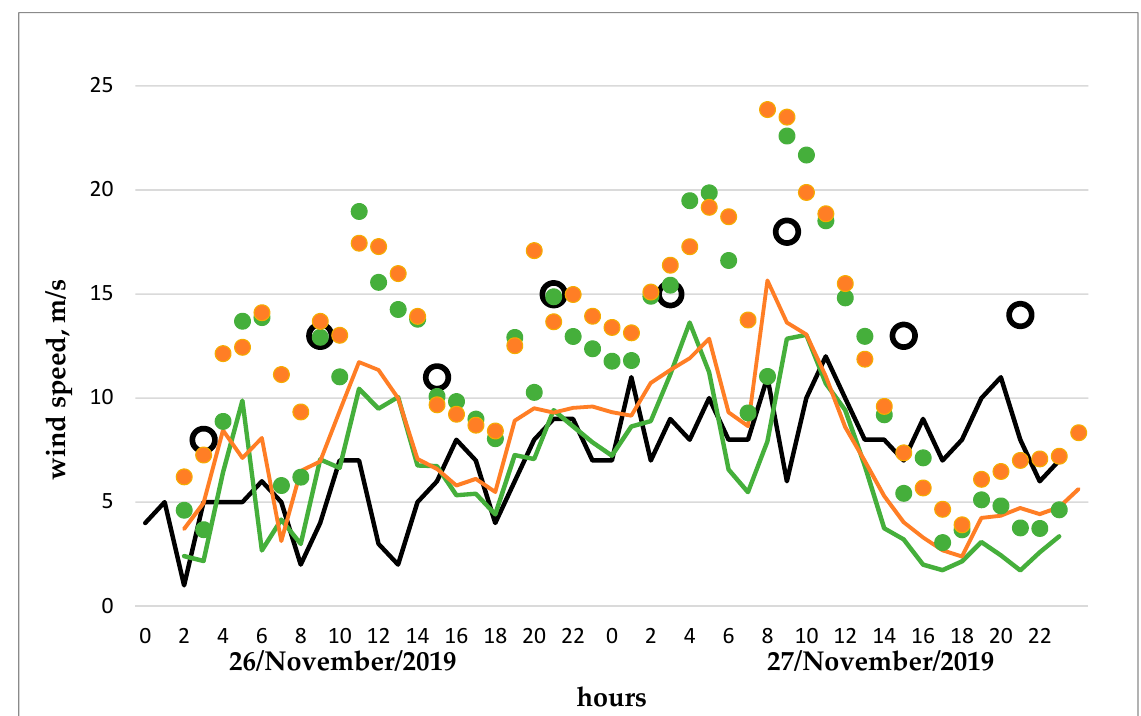
Figure 9. ICON ‐ A6.5 and ICON ‐ A2: 10 m wind speed and wind gusts in Honningsvåg (71°01’ N, 25°59’ E) on 26–27 November 2019, according to observations and forecast. Black: observations; orange: “ICON ‐ A6.5”; green: “ICON ‐ A2“. Curves show the 10 m wind speed, points and circles show the wind gusts values. Gray rectangle shows the time period of the PL appearance near the coastline and the meteorological station area.